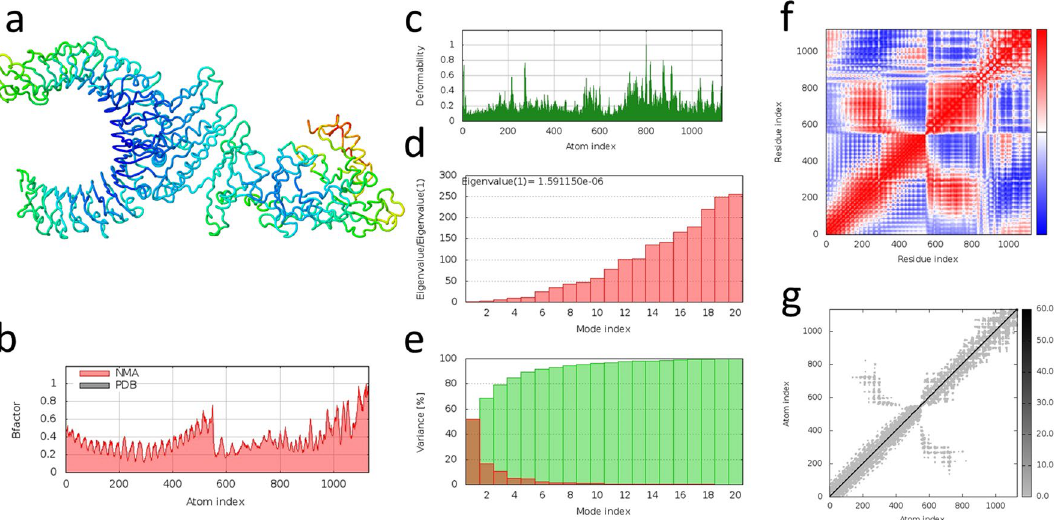
Figure 9. Molecular dynamics analysis of the TLR2 and vaccine complex by the iMODS server (https:// imods. iqfr. csic. es/). ( a ) TLR2 and vaccine docking complex Normal Mode Analysis (NMA) highlighting areas of low mobility (blue) to high mobility (red). ( b ) B-factor values with regional mobility scores from 0 (lowest) to 1 (highest). These values are experimentally similar to NMA mobility analysis in a. ( c ) Deformability index of each residue in the complex with higher values reflecting a higher capacity to deform. ( d ) Eigenvalue. The lower the value, the easier it is to deform the complex. ( e ) Variance is inversely related to the eigenvalue. Green indicates cumulative variances while red indicates individual variances. ( f ) Covariance map with correlated (red), uncorrelated (white) or anti-correlated (blue) motions. ( g ) Elastic network where darker grey areas indicate higher